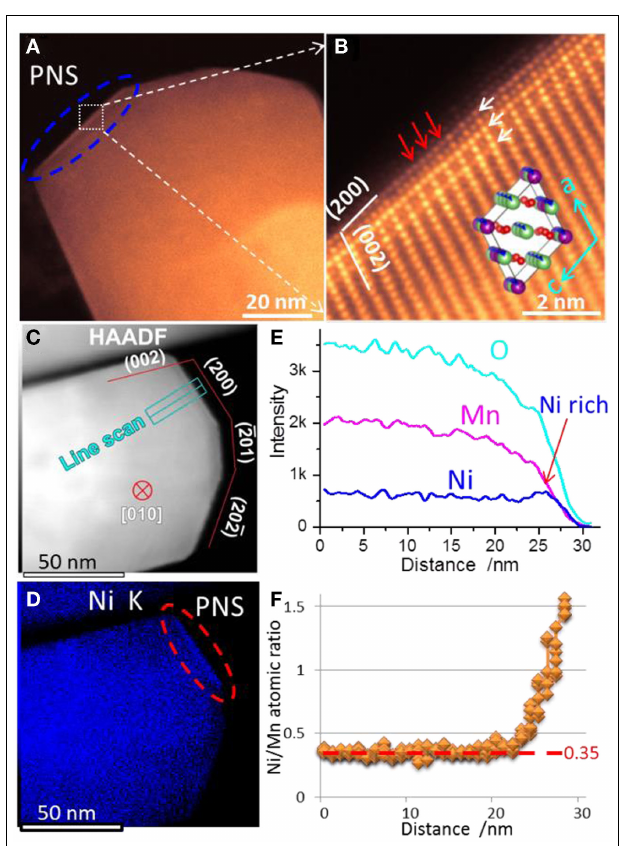
FIGURE 4 | (A) Low magnification and (B) high-resolution STEM-HAADF images of the PNS layer in a pristine particle. White arrows in (B) indicate ordered features along (200) planes. Red arrows in (B) indicated Li slabs being inserted heavy TM cations in the PNS layer. A [010] direction C2/m crystal structure is shown as inset map in (B) . (C) STEM-HAADF image of EDS mapping area. The particle was tilted to [010] zone and its surface facets were determined. (D) Corresponding Ni elemental mapping. (E) Line scan signal counts across the PNS layer, whose location is shown in the STEM-HAADF image; (F) Quantitative Ni/Mn atomic ratios along the line scan. The Ni/Mn ratios are around 0.35 in bulk region, which is close to the designed value 0.33 (Yan et al., 2015). Reprinted with permission from Yan et al. (2015). Copyright 2015 American Chemical